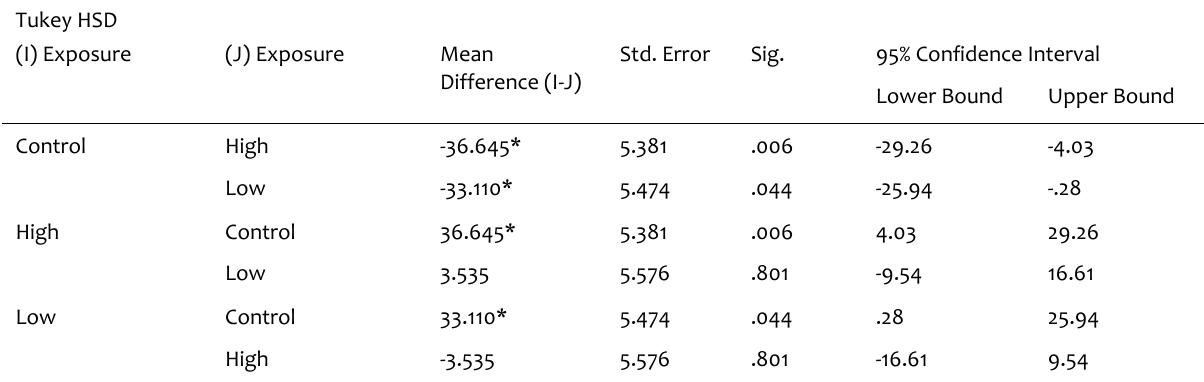
Table IV. Post hoc analysis of the One-Way ANOVA analysis, showing the siginificant differences between different treatment